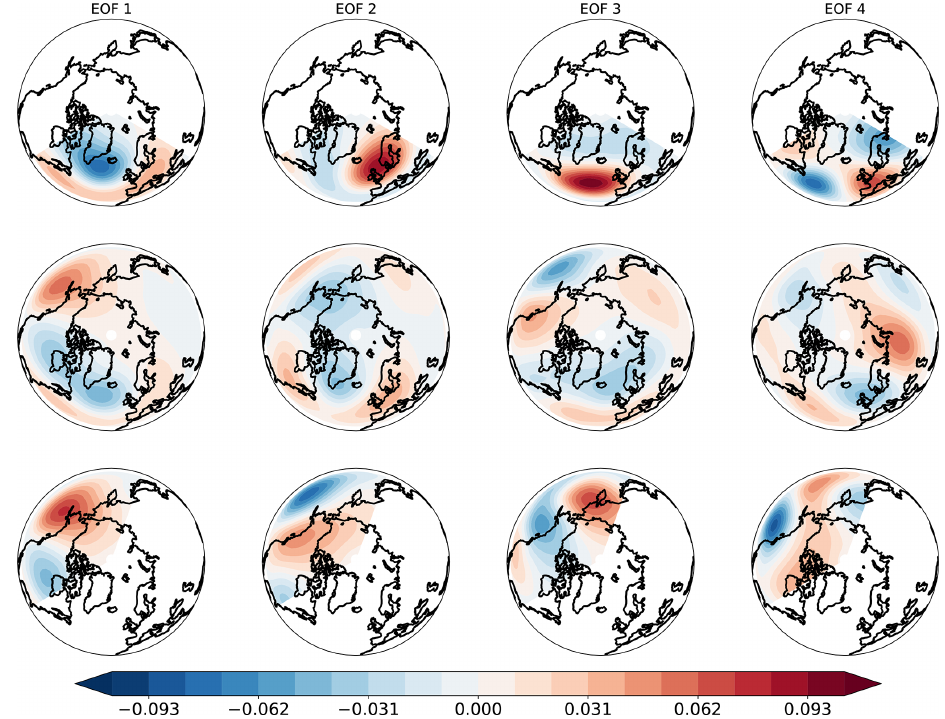
Figure A1. Patterns of the four leading EOFs for DJF: EAT (first row), NH (second), PAC (third).